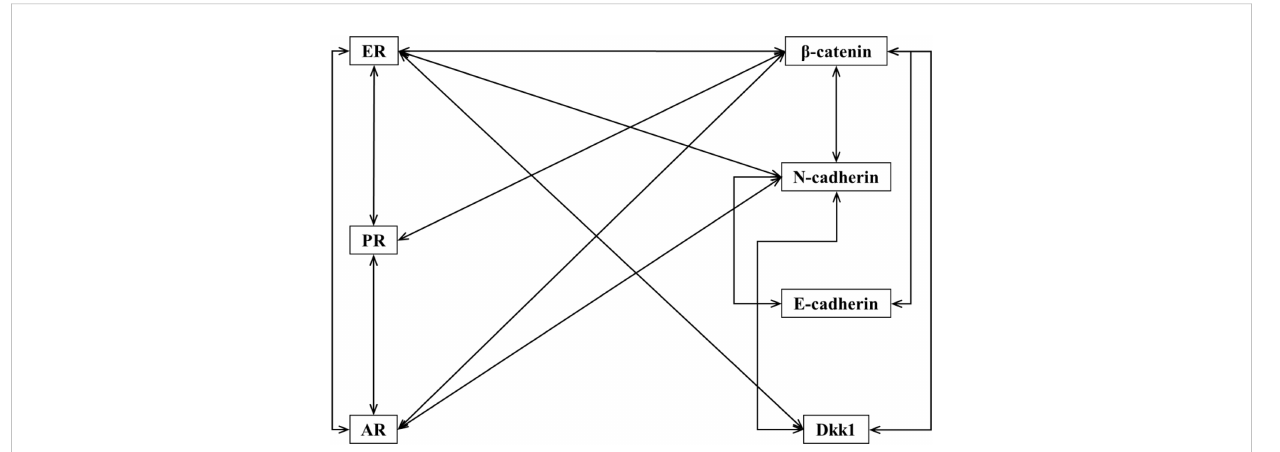
FIGURE 2 Correlations between expression of different molecular markers. Lines connect IHC markers with positive and statistically signi fi cant correlation in their expression in tumours